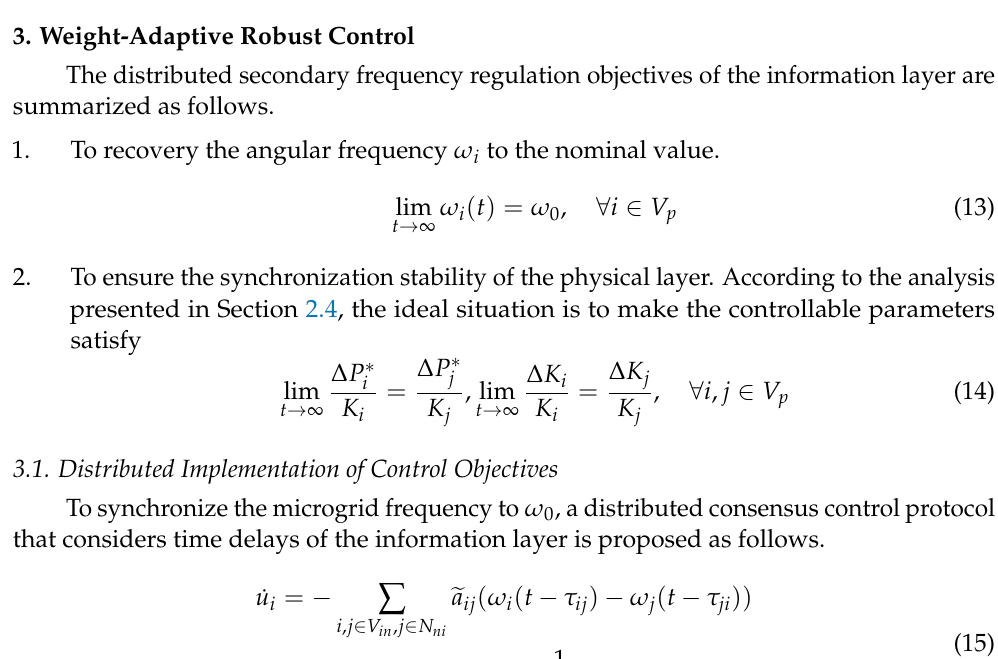
Figure 2. Three cases when P ∗